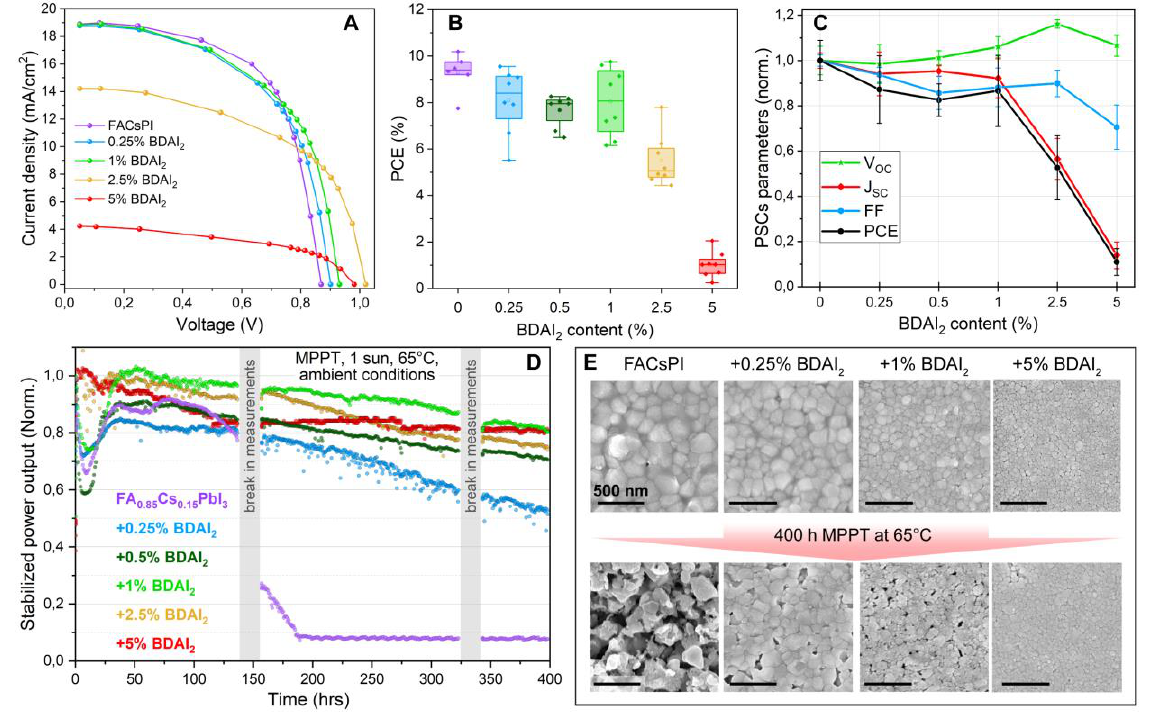
Figure 5. ( A ) Quasi-steady-state J – V curves of record FA 0 . 85 Cs 0 . 15 PbI 3 -based devices with 0.25, 1, 2.5, and 5% BDAI 2 additive. ( B ) Distribution of absolute PCE values of FA 0 . 85 Cs 0 . 15 PbI 3 -based PSCs with a different BDAI 2 content. ( C ) The dependence of FF, V OC , J SC , and PCE parameters as a function of BDAI 2 content. Each parameter is normalized by the corresponding average value of the reference devices. ( D ) Normalized values of stabilized power output (SPO) of encapsulated devices with a different BDAI 2 amount. Vertical grey regions illustrate the technical interruptions in signal regis- tration. During this time, light soaking and heating did not stop; the devices were loaded at a voltage near the MPP conditions. ( E ) SEM images of FACsPI + x% BDAI 2 perovskite surface in PSCs before (top row) and after 400 h of MPPT at 65 °C (bottom row). All scale bars correspond to 500 nm.